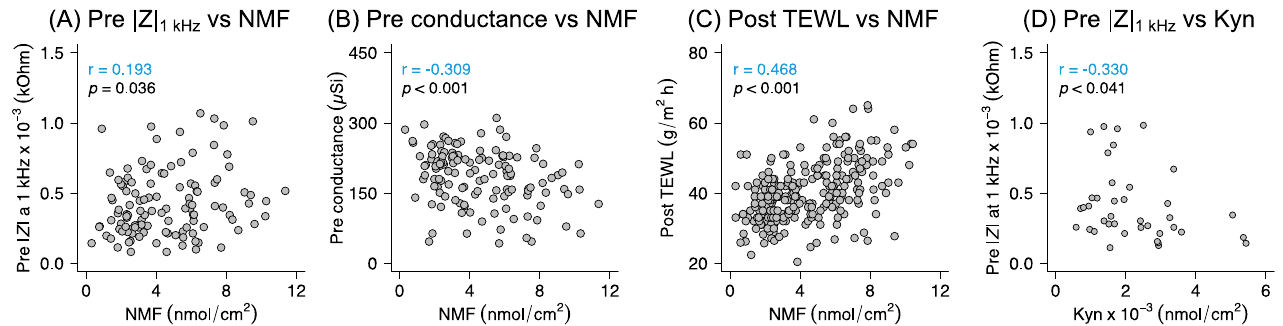
Figure 5. Spearman’s correlation plots between the biophysical properties of the skin barrier and the collected amounts of analytes (i.e., NMF). Correlation between the initial skin resistance ( A ), the initial skin conductance ( B ), post- TEWL ( C ), and the total quantity of collected NMF. Correlation between the collected quantity of Kyn and the initial skin resistance ( D ).